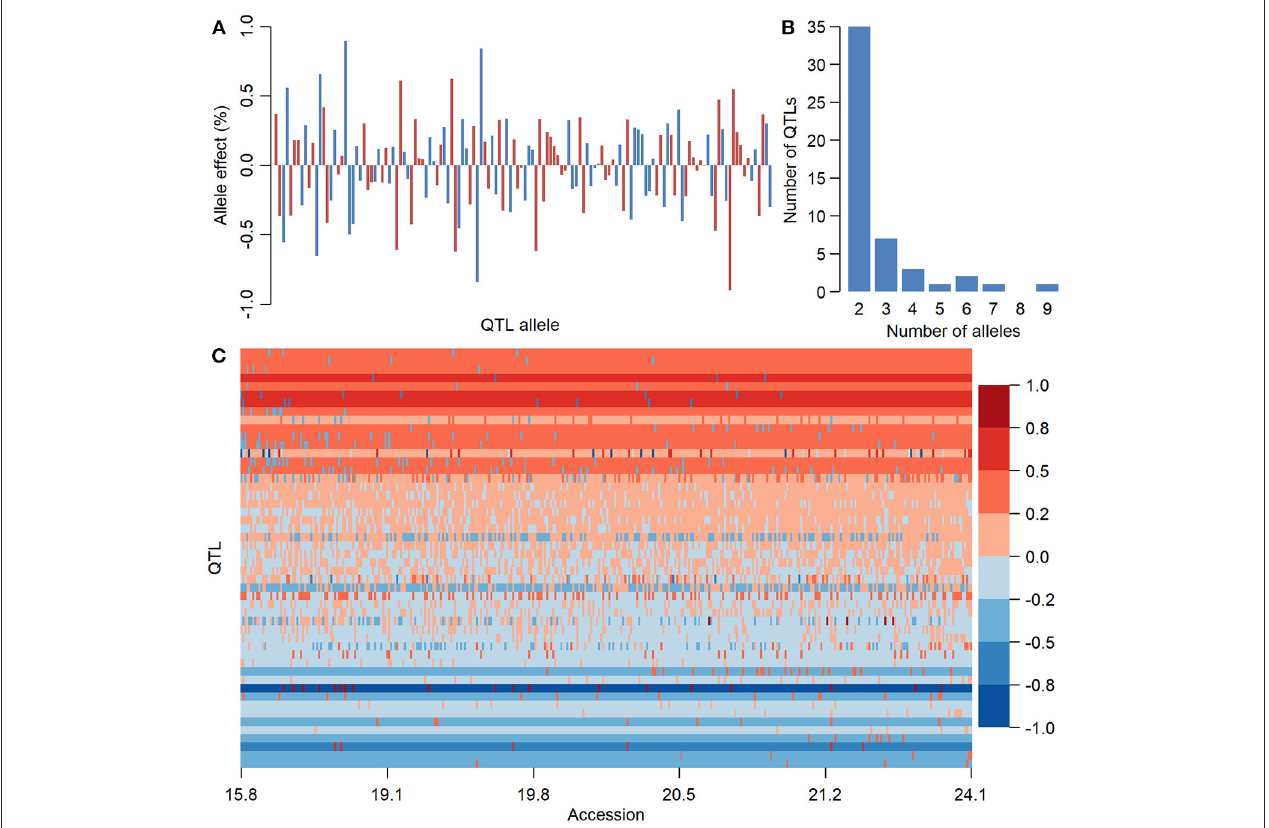
FIGURE 2 | The information of seed oil content QTL-allele matrix of CSLRP. (A) Effect distribution of 136 alleles on the 50 loci for seed oil content in CSLRP. A bar represents an allele. (B) Distribution of number of alleles on the 50 loci for seed oil content (%). (C) Graphical representation of seed oil content QTL-allele matrix of CSLRP. The horizontal axis represents accessions arranged in a rising order of their oil content (%), while the vertical axis represents QTL arranged in a rising order of their positive allele frequency. Each row represents the allele distribution among accessions for a QTL, while each column indicates the allele constitution of an accession over all QTLs. Allele effects are expressed in color cells with warm colors indicating positive effects and cool colors indicating negative effects, and the color depth indicates effect